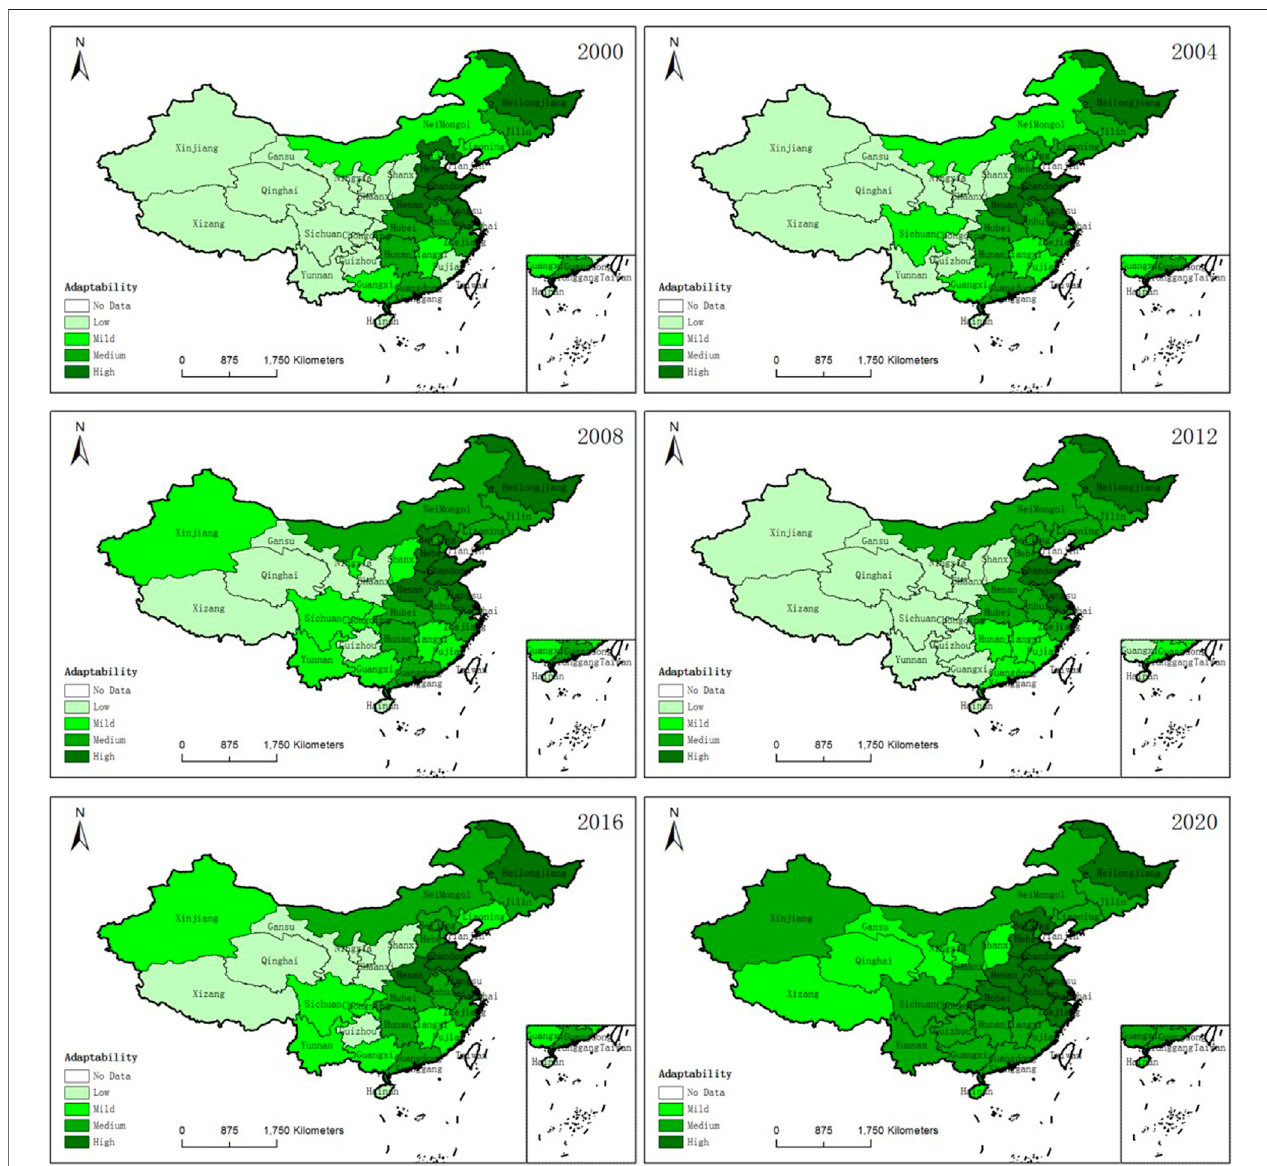
FIGURE 4 | Temporal and spatial variation of agricultural fl ood adaptability in China.